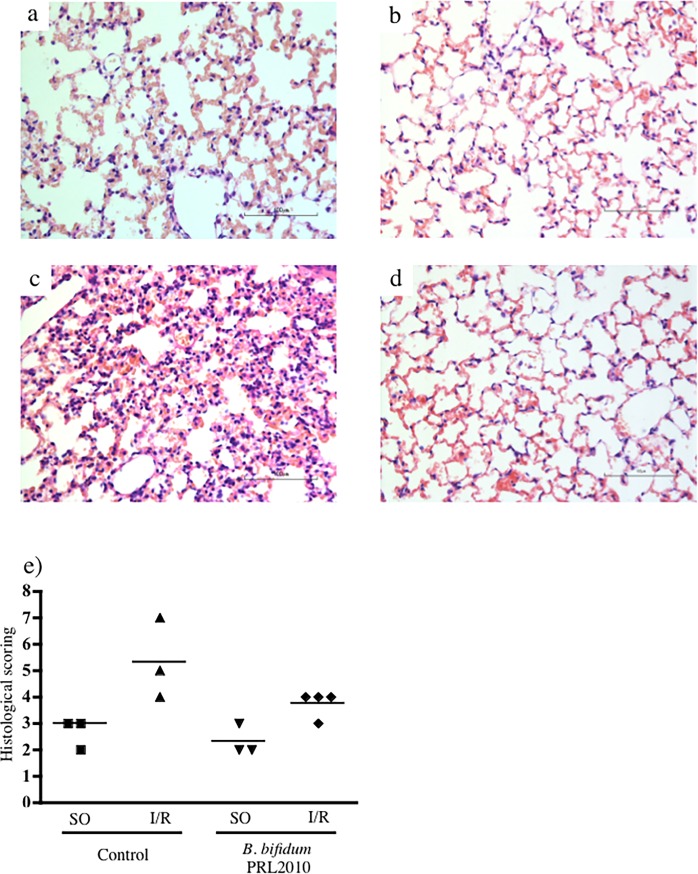
Lung histology.Representative hematoxylin-eosin stained sections of lung specimens harvested from SO animals treated with vehicle (a) and B. bifidum PRL2010 (b) and from I/R mice pre-treated with vehicle (c) and B. bifidum PRL2010 (d) (scale bar: 100μm). The acute lung injury caused by mesenteric I/R was characterized by diffuse congestion of septae, inter- and intra-alveolar cell infiltration and hemorrhage (c); pre-treatment with B. bifidum PRL2010 attenuated lung injury in all treated mice (d). Damage scoring of lung histological sections, according to Matute-Bello et al. [27], reported in panel e, shows the ability of B. bifidum PRL2010 to alleviate the I/R-induced remote injury (e).